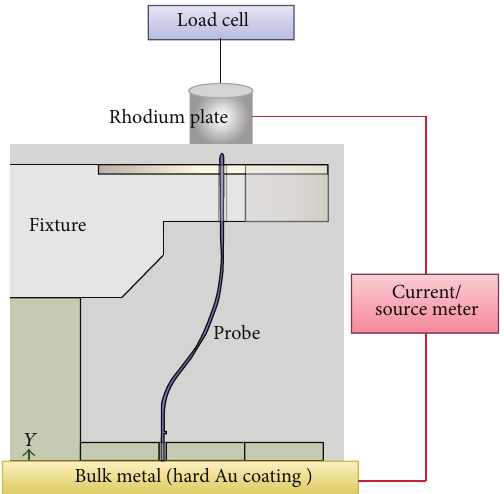
Figure 7: The schematic diagram of the test setup for probe fatigue